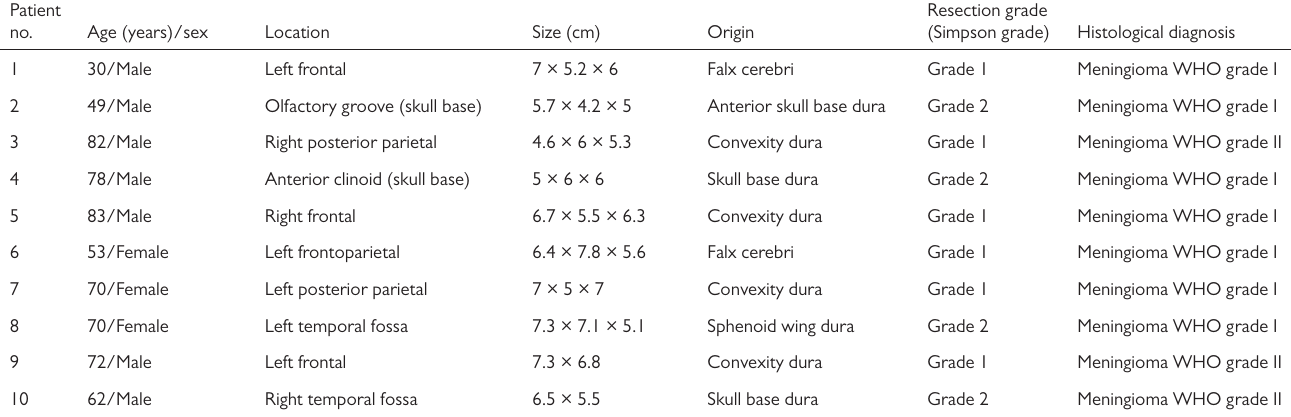
Table 1. Demographic, Radiological, Surgical, and Histological Characteristics of Patients who Underwent Surgery for Giant Intracranial Meningioma Patient